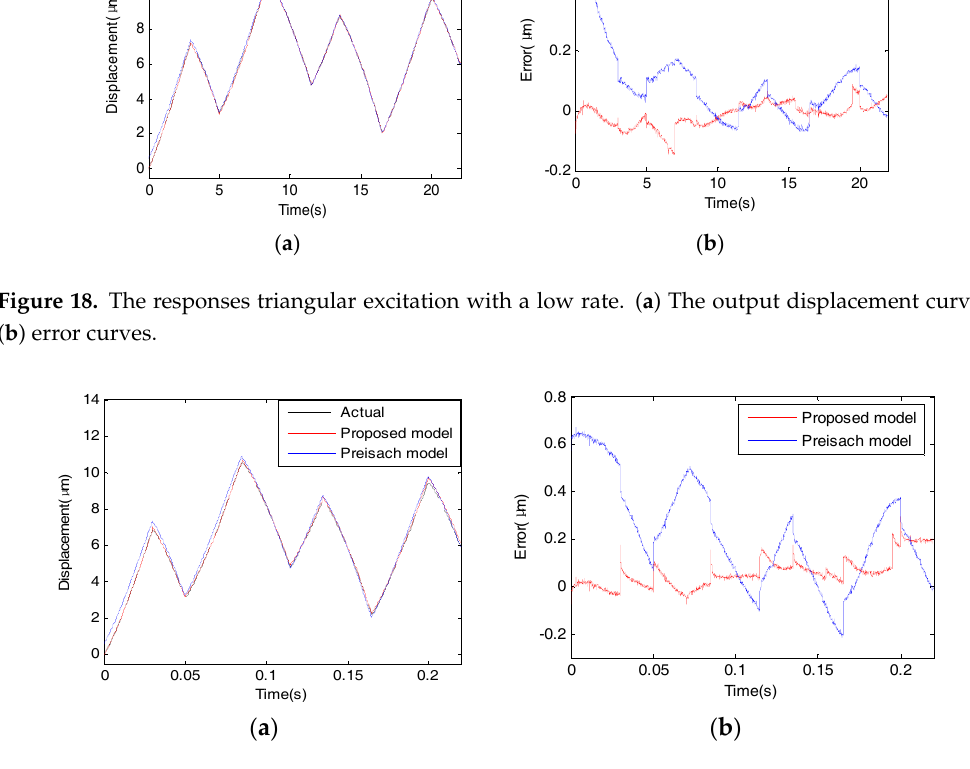
Figure 18. The responses triangular excitation with a low rate. ( a ) The output displacement curves; ( b ) error curves.